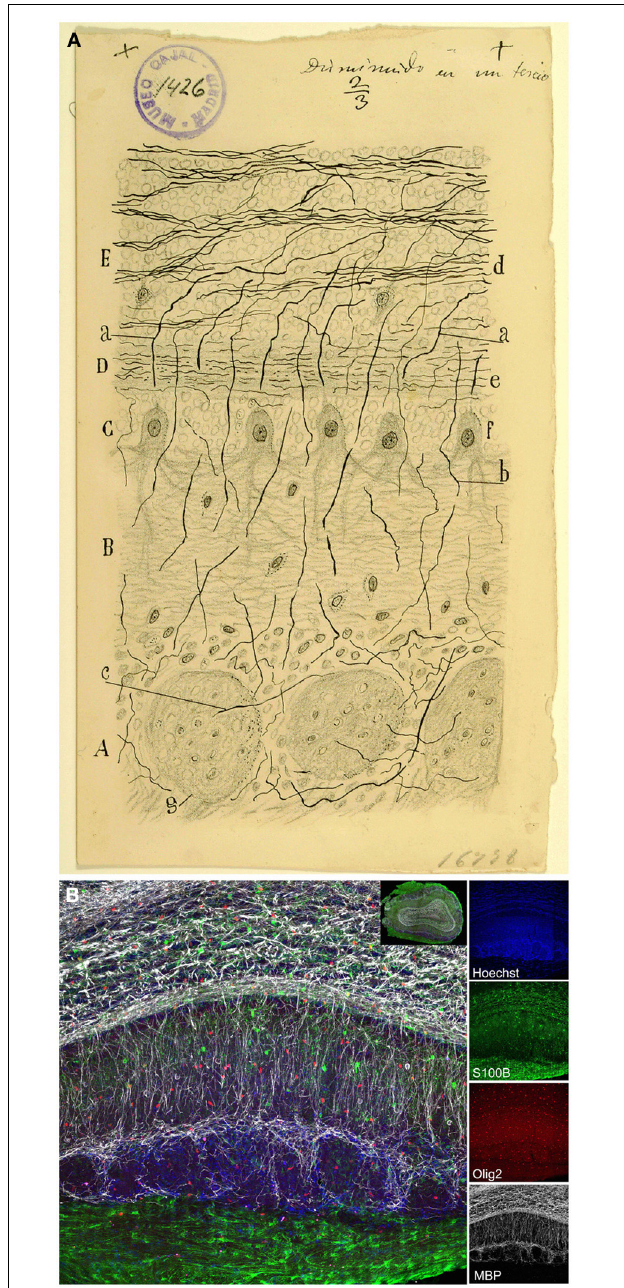
FIGURE 10 | Myelin. (A) Original drawing from Cajal of an olfactory bulb section of a month-old rat. Weigert-Pal method (Ramón y Cajal, 1890b). Layer of the glomeruli (A) , lower molecular layer (B) , mitral layer (C) , higher molecular layer (D) , coating the grains (E) . (a) myelin fiber corresponding to the cylinder-axis of mitral cells; (b) cylinder-axis of mitral cells; (c) core fiber from within the glomeruli; (d) bundles of fibers in the layer of grains; (e) thin horizontal strands from the higher molecular area; (f) mitral cells; (g) glomerulus; Cajal Legacy (Instituto Cajal, CSIC, Madrid, Spain). (B) Immunohistochemistry with different glial markers: Olig2 (oligodendrocyte progenitors, red), S100 β (astrocytes, green), and myelin binding protein (MBP, gray). Nuclei labeled with Hoechst (blue). Inset shows overall view of the olfactory bulb (coronal section) labeled with the markers explained